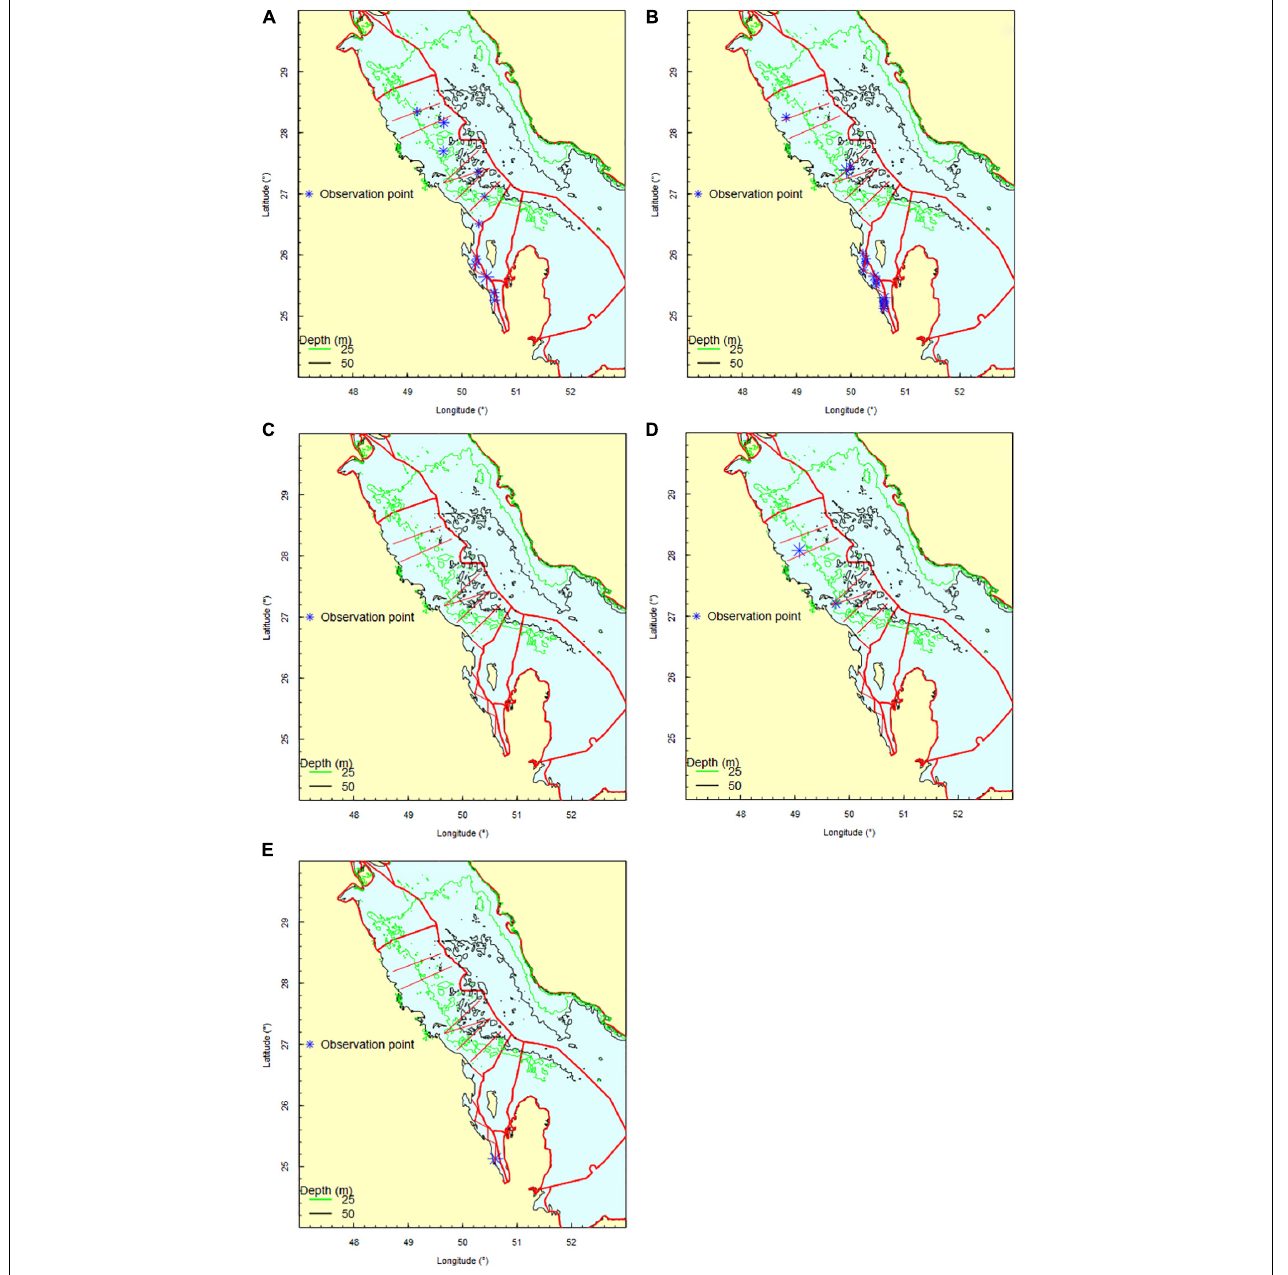
FIGURE 5 | Observation tracks (red straight lines) and observation points (blue asterisk) of bottlenose dolphins (A,B) , humpback dolphins (C,D) and dugongs (E) during the two surveys (Spring 2018 and Spring 2019).